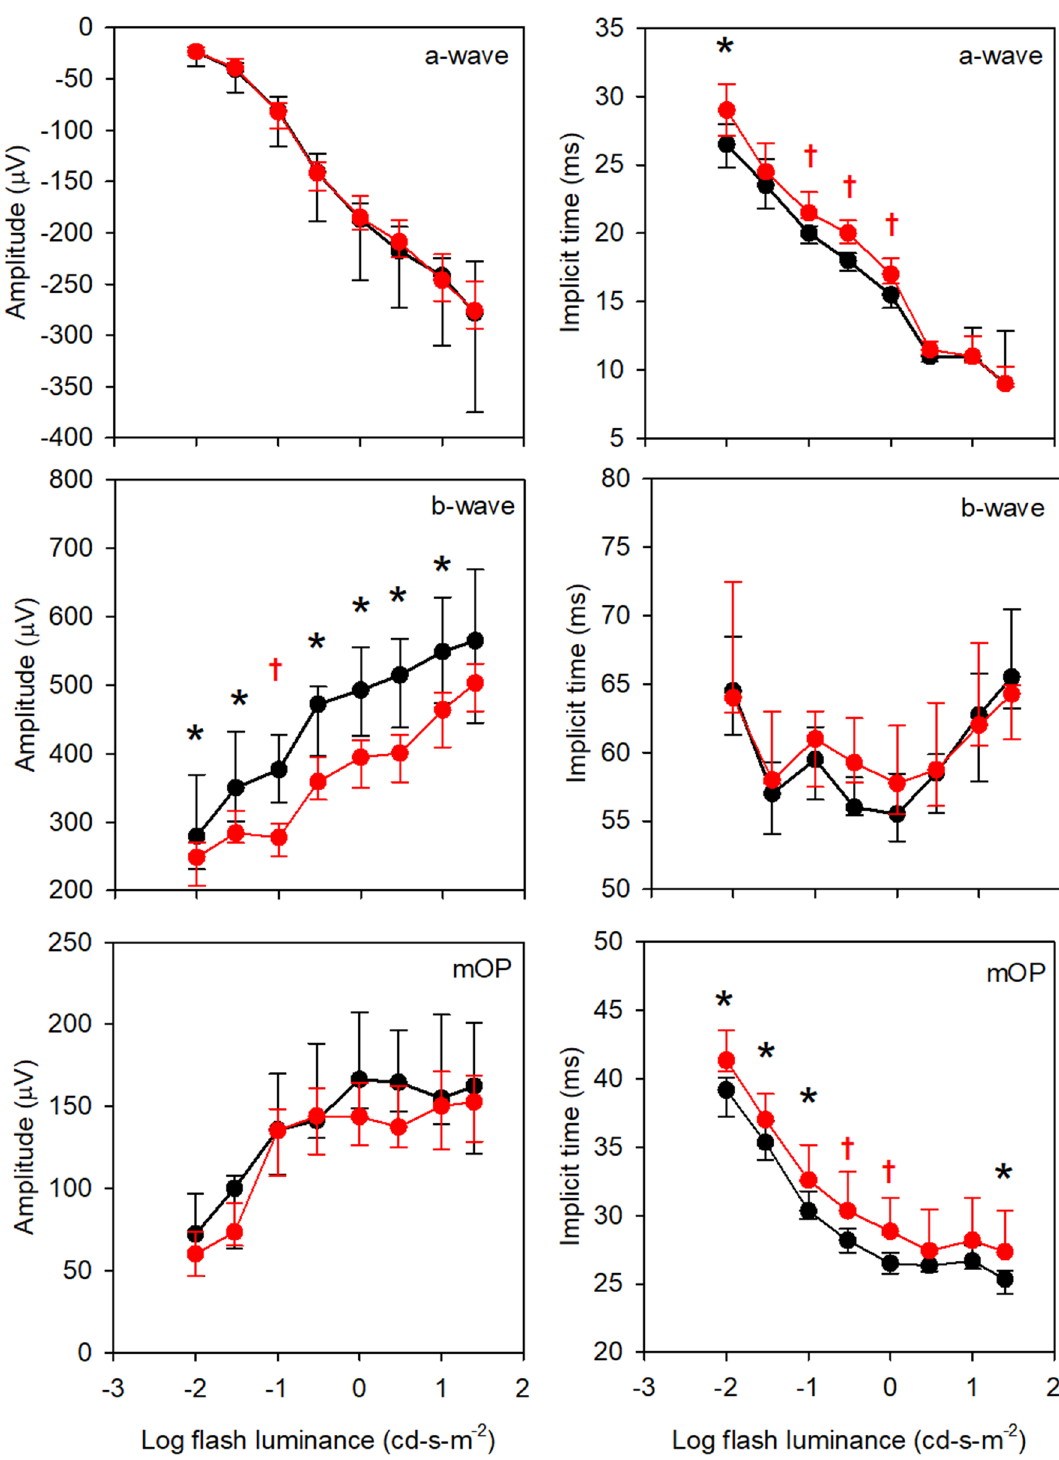
Figure 2. Median response amplitude (left column) and implicit time (right column) for the WT (black) and 5xFAD (red) mice as a function of log flash luminance. Measurements were obtained under dark-adapted conditions. Error bars represent 95% confidence intervals derived by bootstrapping. Each row represents a different waveform component, as indicated in the panels. The asterisks mark statistically significant differences between the WT and 5xFAD groups at the p = 0.05 level, whereas daggers represent Bonferroni corrected differences at the p = 0.0063 level ( p =